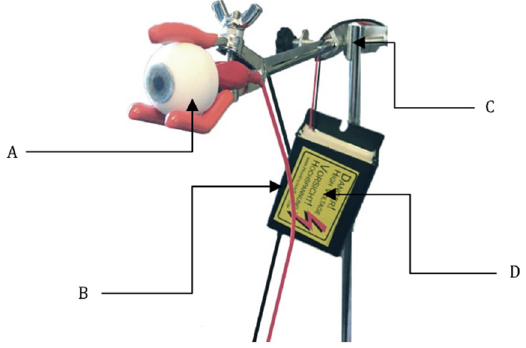
Figure 4. Robotic eye test set-up for measuring the maximum and minimum pupil dilation range: ( A ) robotic eye prototype; ( B ) power supply to the EAP membrane; ( C ) support stand for the experiment with non-conductive claw; ( D ) negative ion generator.